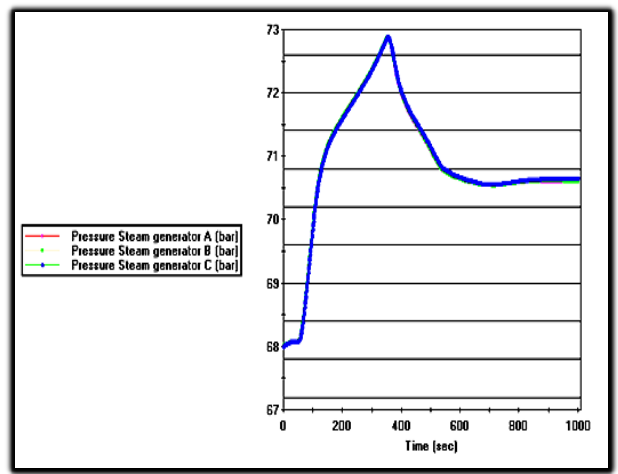
Fig. 14 . Dynamics of steam generator